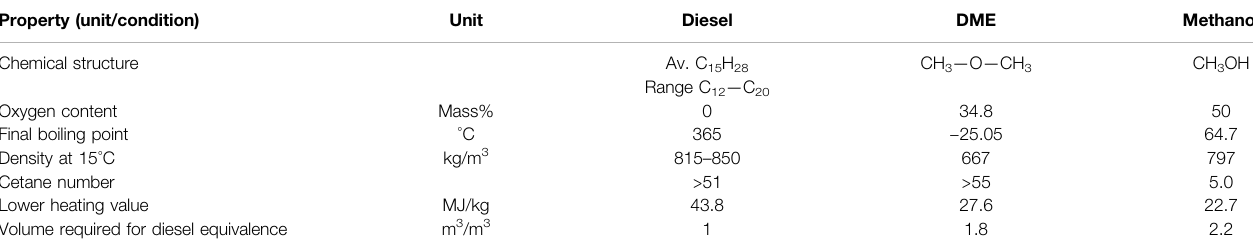
TABLE1| ThecomparisonbetweenthepropertiesofDME,dieselandmethanolcanbeseenin(Arcoumanisetal.,2008),(WorldwideFuelCharterCommittee,2019),(Wang et al., 2020), (US deperatment of energy, 2021): Property